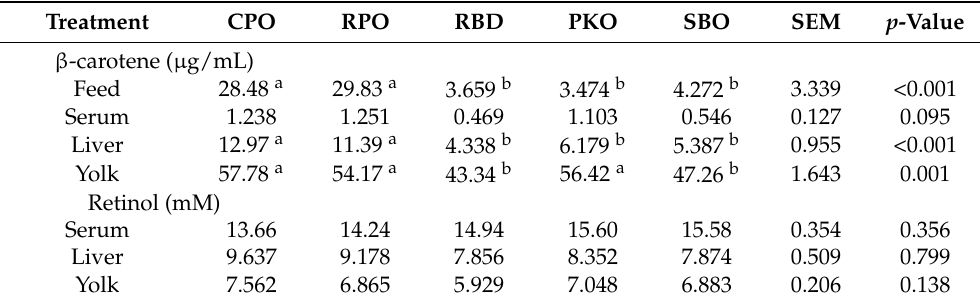
Table 6. Feed, liver, serum and yolk retinol, β -carotene and α -tocopherol profiles in laying hens fed different oils.